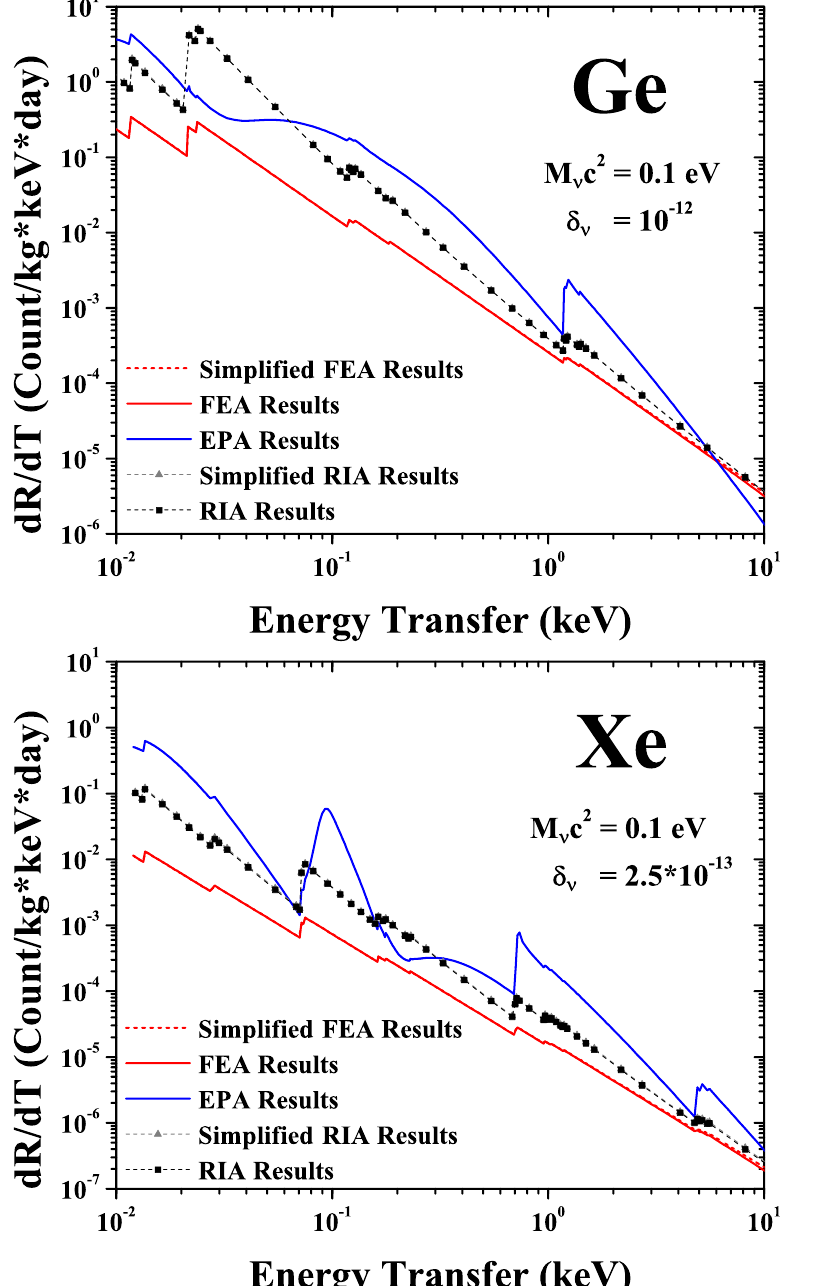
Figure 9 . The differential reaction event rates for atomic ionization process induced by millicharged neutrinos for HPGe and LXe detectors. The neutrino mass is chosen to be m 2 = 0 . 1 eV, and the ν c neutrino millicharge is set as δ = 10 − 12 for HPGe detectors and δ = 2 . 5 × 10 − 13 for LXe detectors. ν ν In this figure, the horizontal axis represents the energy transfer T , and the vertical axis represents the differential event rate dR/dT in unit of cpkkd. The same as in figure 6, the red solid lines correspond to the FEA result; red dashed lines represent the simplified FEA results; blue lines stand for the EPA results; black squares display the RIA results; gray triangles show the simplified RIA